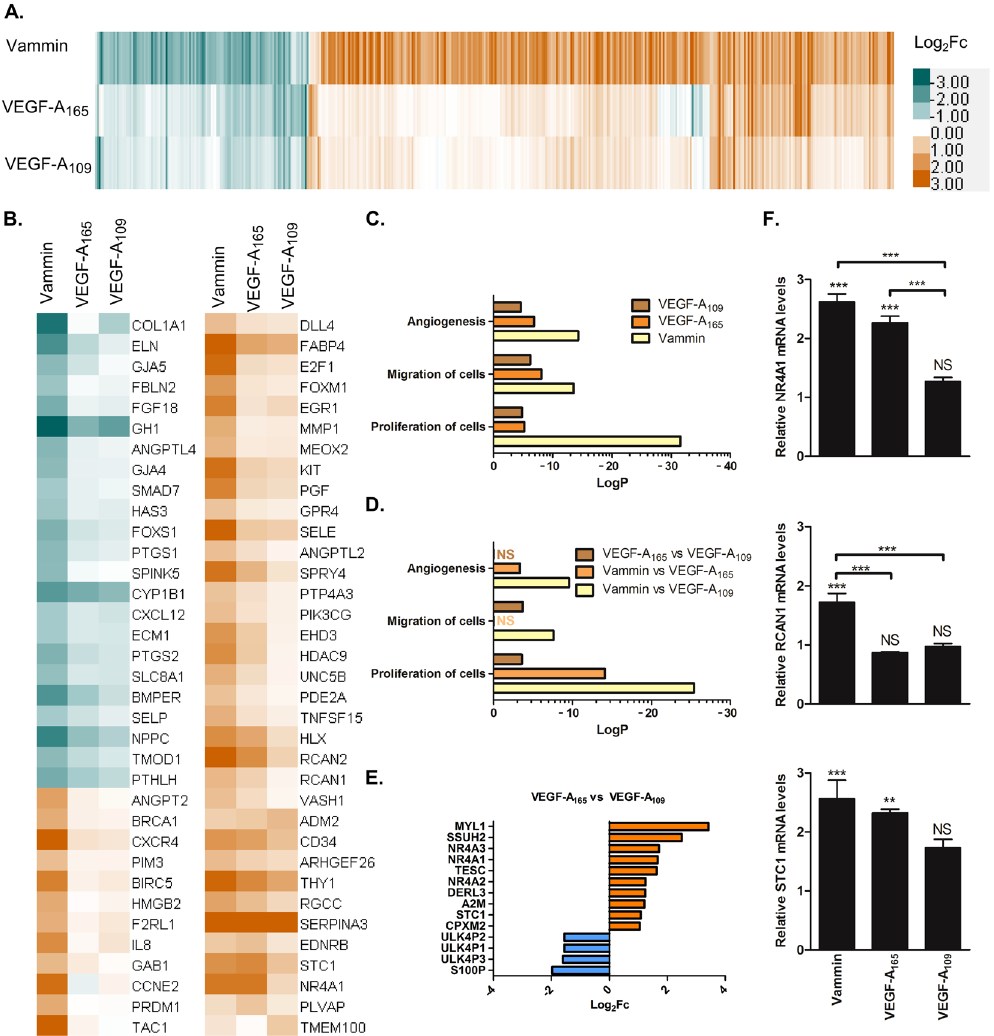
Figure 5. ( A ) Heatmap of fold changes (Log 2 ) in gene expression levels between vectors encoding the tested factors and the AdCMV control vector. ( B ) Heatmap of fold changed (Log 2 ) of the angiogenesis associated genes identified in the gene ontology analysis. ( C and D ). Gene ontology analysis using the Ingenuity Pathway Analysis: The top 3 most significantly enriched physiological functions are presented. ( E ) The genes differentially expressed between VEGF-A 165 and VEGF-A 109 . F. qRT-PCR analysis of the expression of NR4A1, RCAN1 and STC1 in human dermal blood endothelial cells. The data is presented as mean ± SEM. ** P < 0.01, *** P <